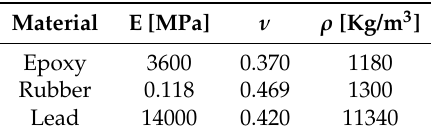
Table 1. Material